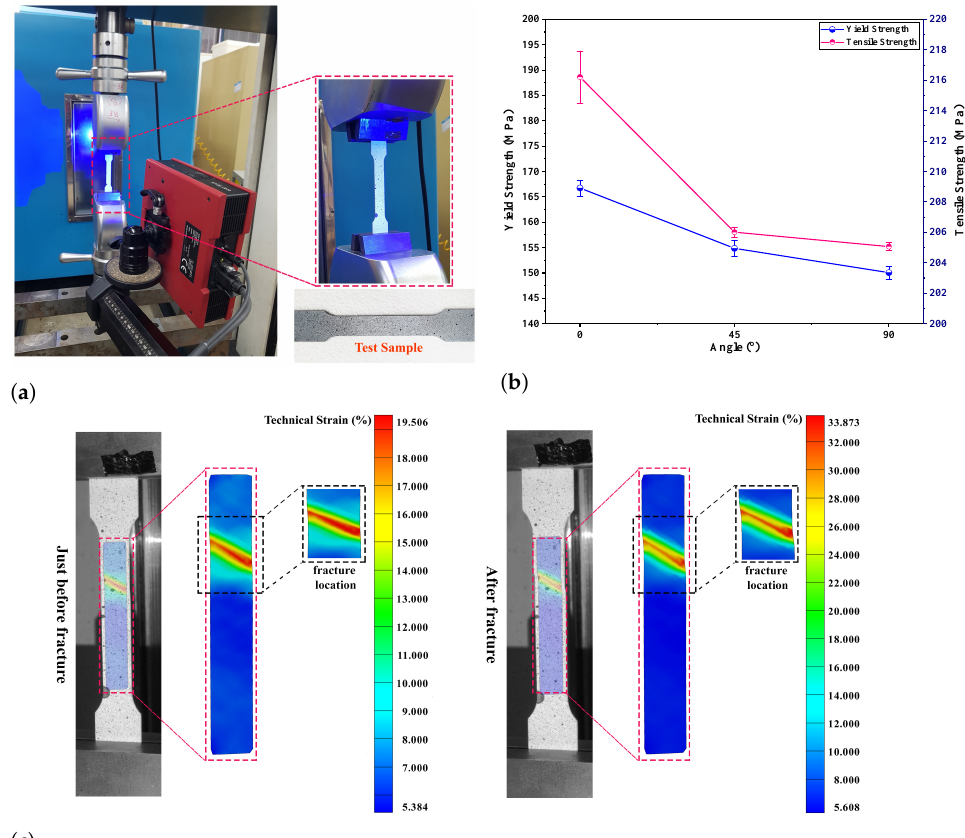
Figure 3. ( a ) Experimental setup used for the uniaxial tension test with Aramis; ( b ) Yield and tensile strength data at 0 ◦ , 45 ◦ and 90 ◦ to the RD ; ( c ) Major strain measurements by Digital Image Correlation (DIC) just before and after